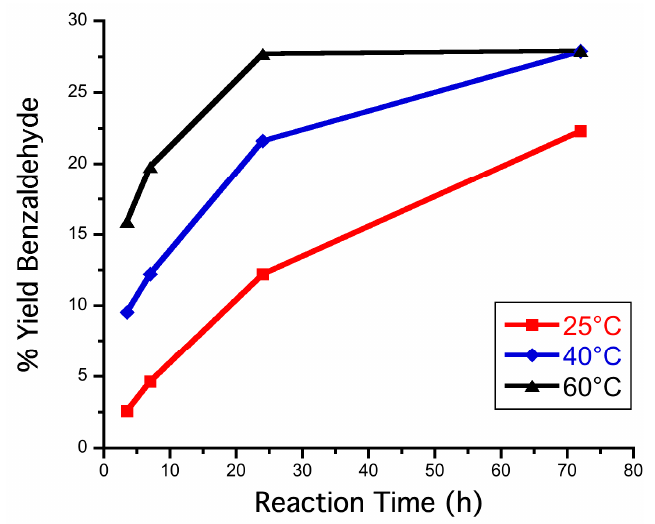
Figure 1. Toluene oxidation in biphasic system PhCH 3 -H 2 O at different temperatures: (red) 25 °C, (blue) 40 °C, (black) 60 °C. Conditions: V = 20 mL; PhCH 3 :H 2 O 1:1 v/v, pH = 1, H 2 O 2 0.05 mmol, NH 4 VO 3 0.05 mmol, KF = 0.25 mmol. Table 6. Toluene oxidation under air and O 2 atmosphere in a biphasic system PhCH 3 -H 2 O (V = 20 mL; PhCH 3 :H 2 O 1:1 v/v ), pH = 1, after 24 h, at 60 ◦